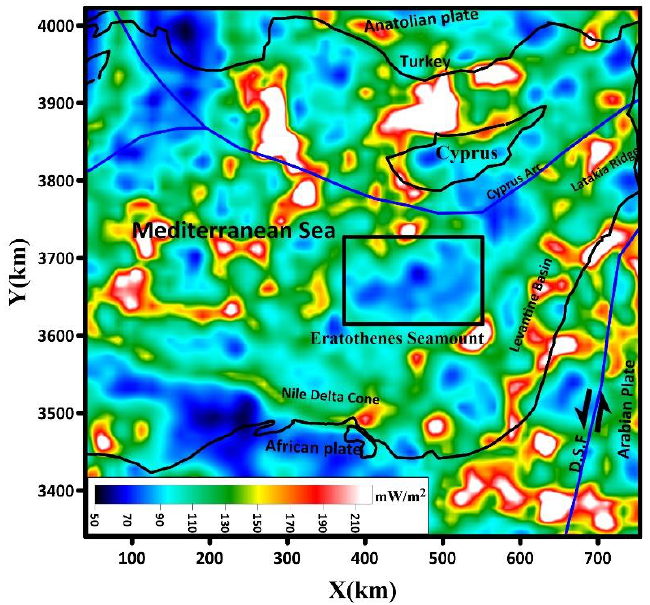
Figure 6. Heat flow map of the Eratosthenes Seamount from Curie point depths.